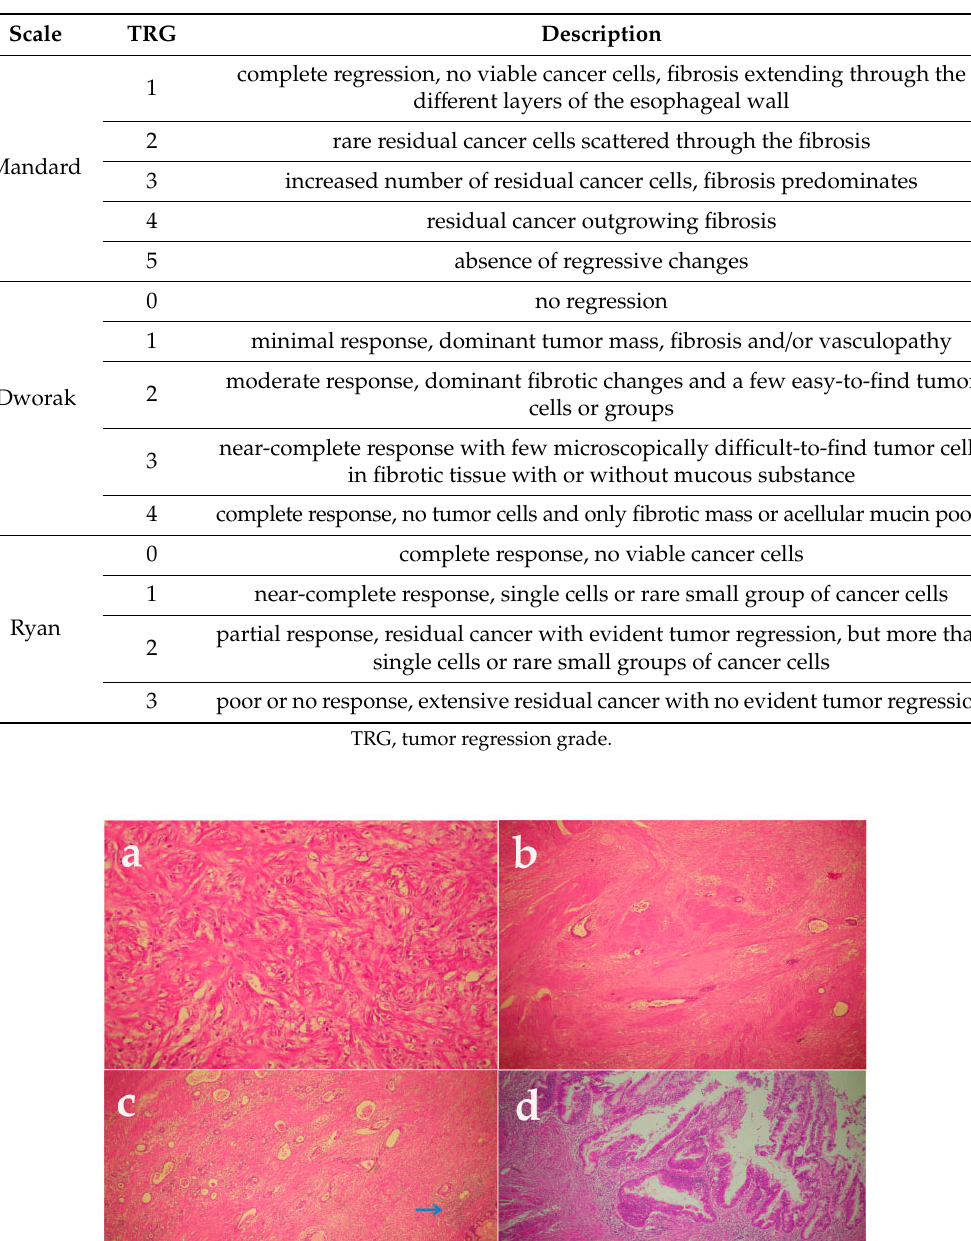
Table 1. The Most Commonly Used Tumor Regression Grade (TRG) Systems.